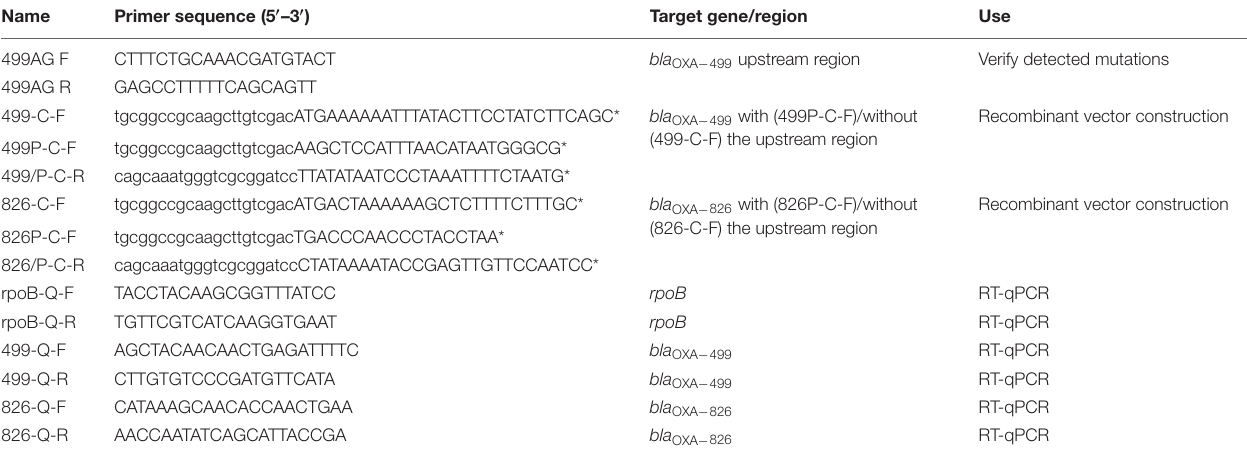
TABLE 1 | Primers used in the